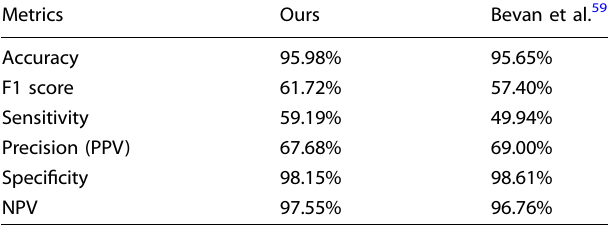
(b): Binary classi fi cation results for prediction horizon at 30 min.